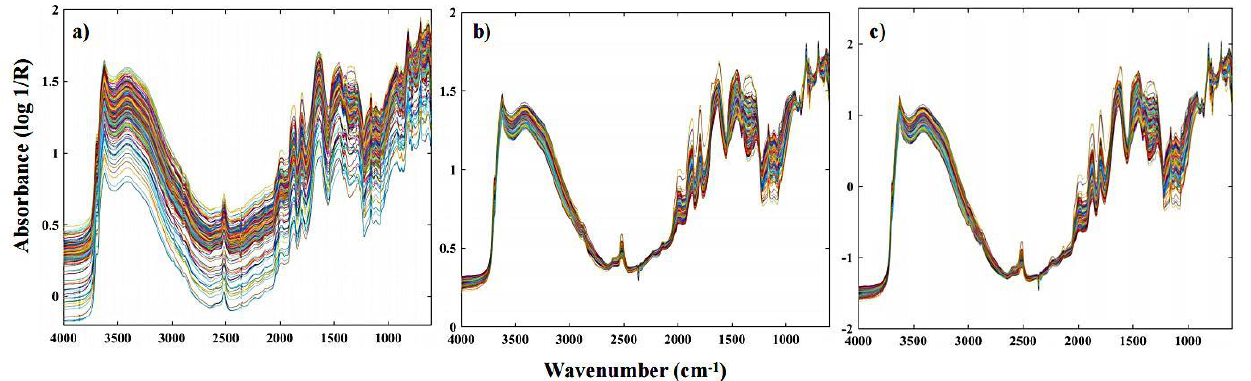
Figure 2. Original soil MIR spectra and spectra after pre-processing. Note: ( a ) original spectra; ( b ) multivariate scattering (MSC); ( c ) standard normal variables (SNV). R: the percentage of diffuse spectral reflectance.